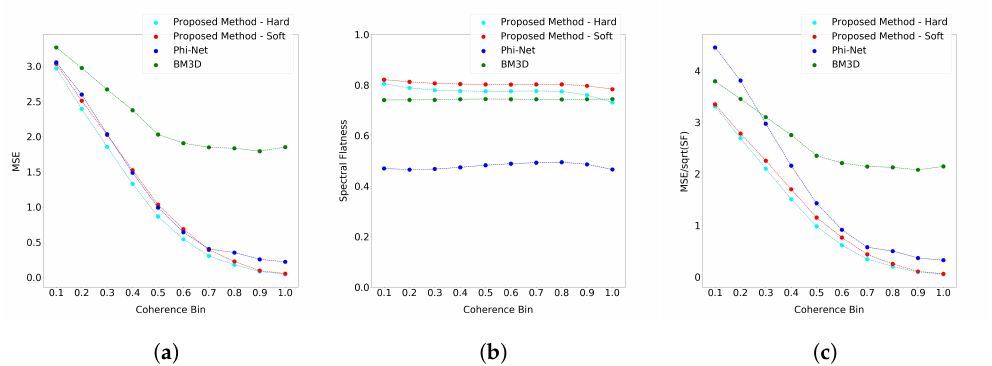
Figure 15. High-frequency case: mean square error ( a ), spectral flatness ( b ) and custom metric ( c ) for all methods under comparison.